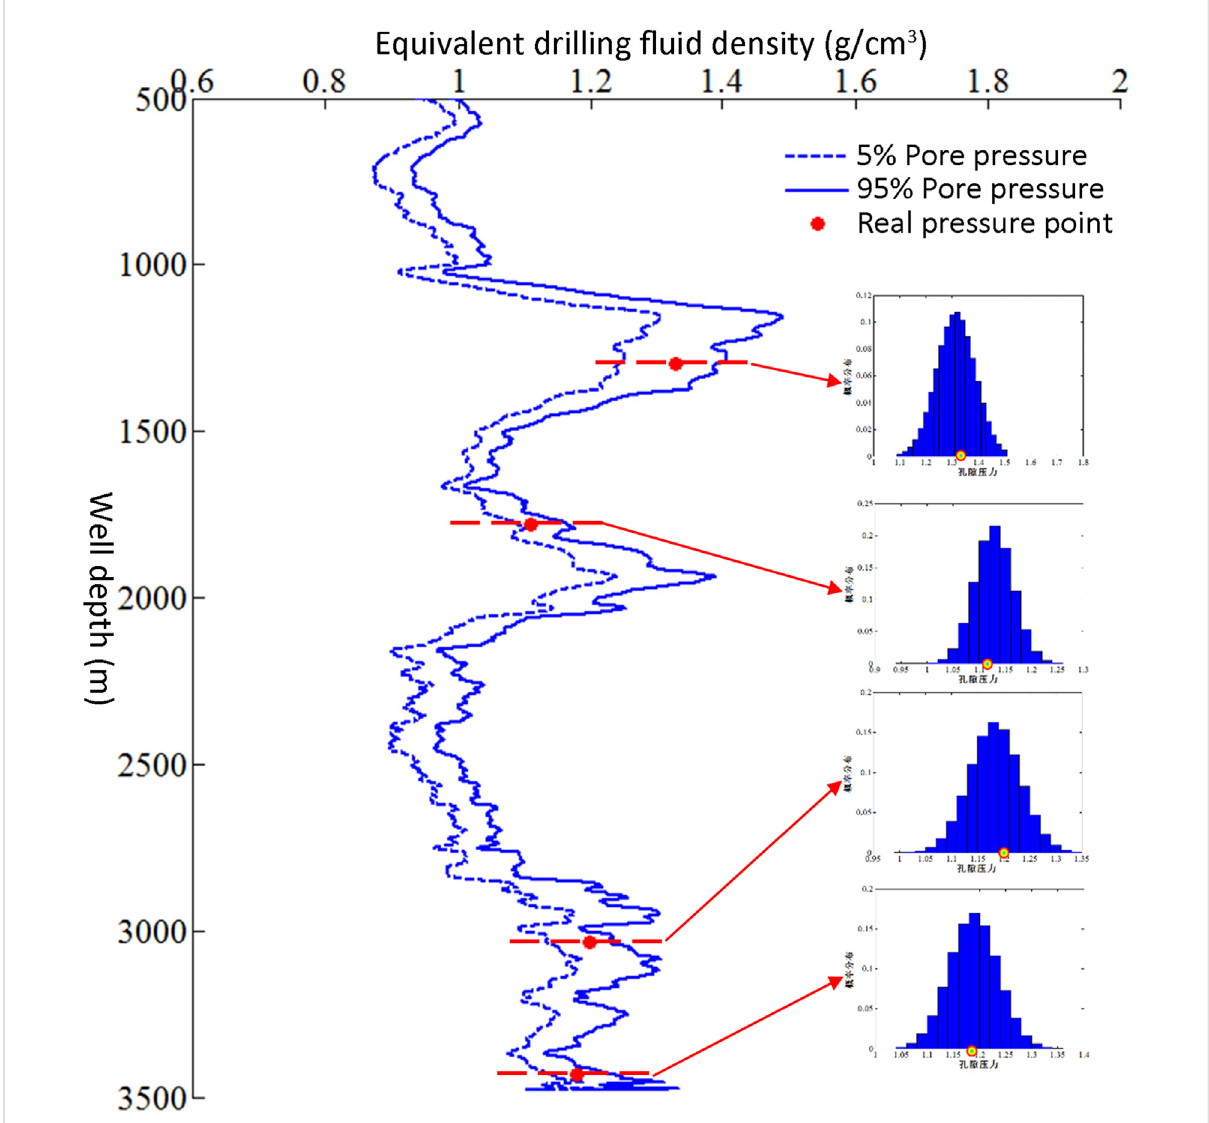
FIGURE 3 Formation pressure pro fi le with